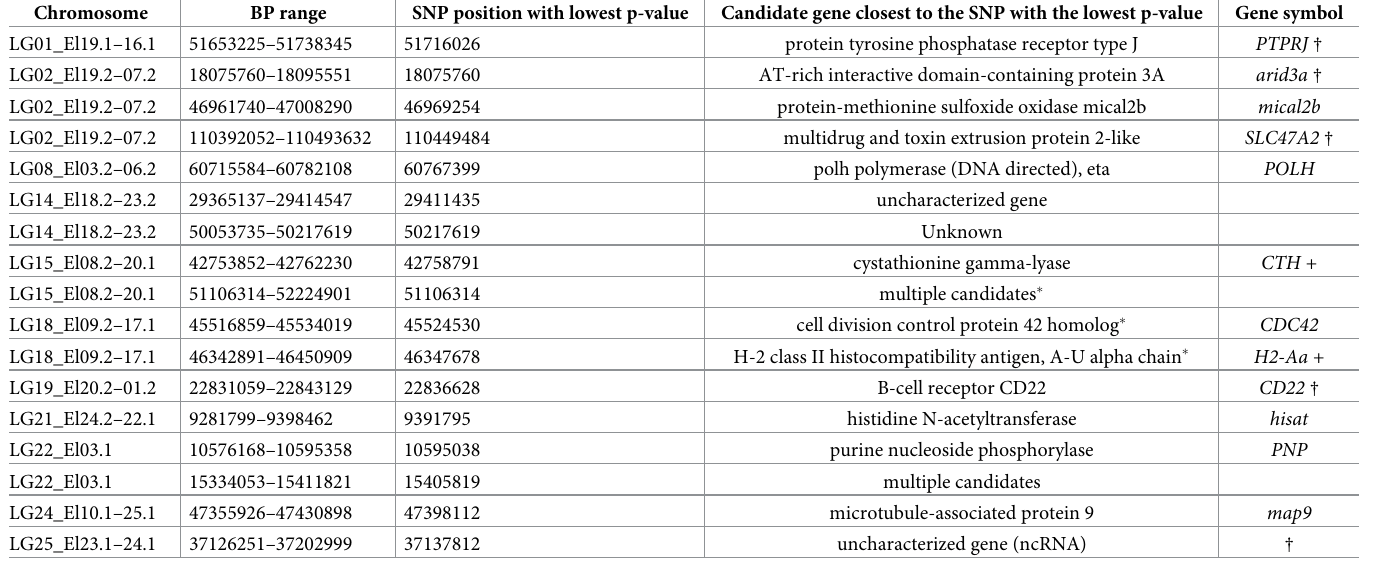
Table 3. Top eigenGWAS peaks identified between